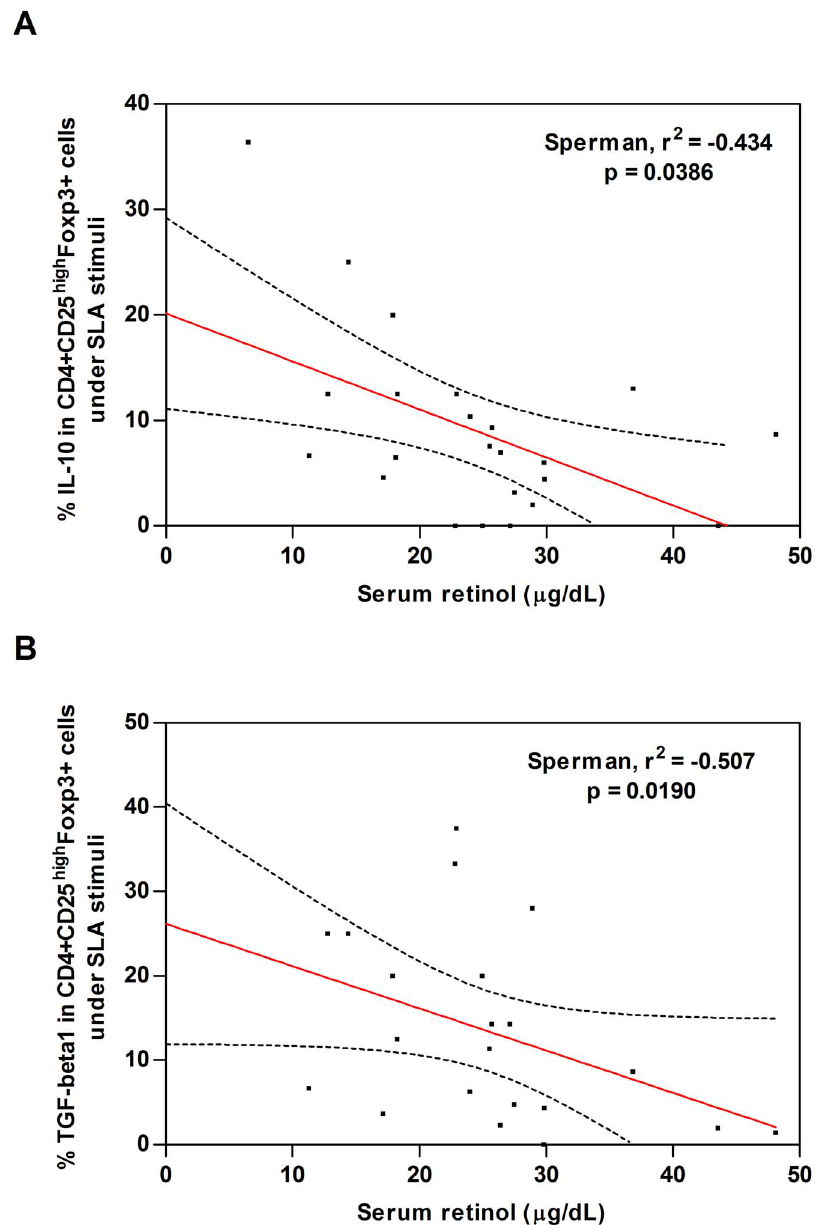
Figure 2. Negative correlation between serum retinol and IL-10 and TGF- b 1 production by CD4 + CD25 high Foxp3 + T cells. A . Represents a negative correlation between serum retinol and IL-10 production in CD4 + CD25 high Foxp3 + T cells after SLA stimulus. B . Represents a negative correlation between serum retinol and TGF- b 1 production in CD4 + CD25 high Foxp3 + T cells after SLA stimulus. Correlation analyzes were performed in VL cases (n=10) and endemic controls (n=16), using Spearman correlation